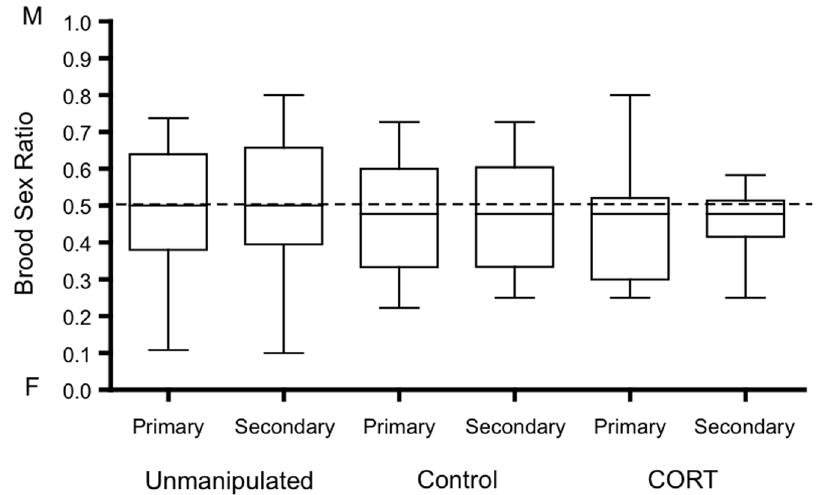
Figure 6. Primary and secondary brood sex ratios between experimental treatments. CORT: mothers fed CORT spiked mealworms during egg laying ( n =24), Control: mothers fed mealworms ( n =24) or un-manipulated mothers ( n =24). Graph shows median and interquartile range. M indicates a male and F indicates a female biased brood sex ratio. Dashed line denotes a 50:50 brood sex ratio.